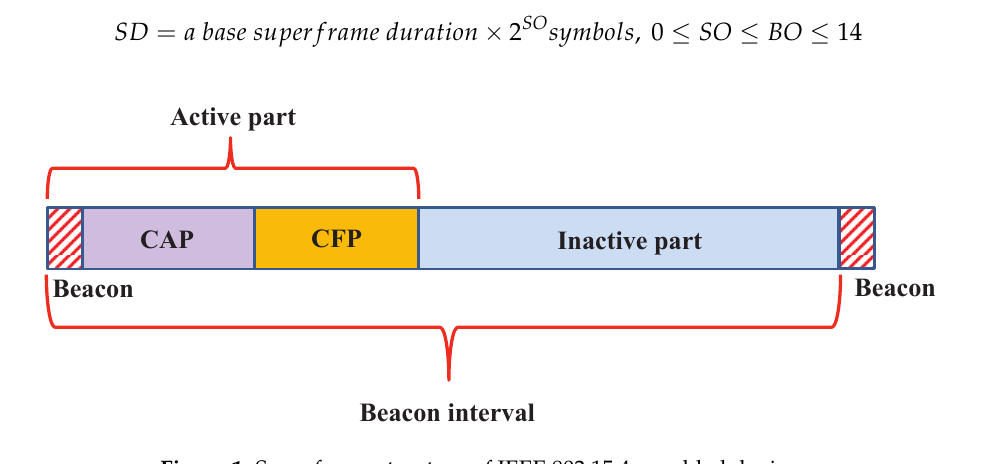
Figure 1. Superframe structure of IEEE 802.15.4e-enabled